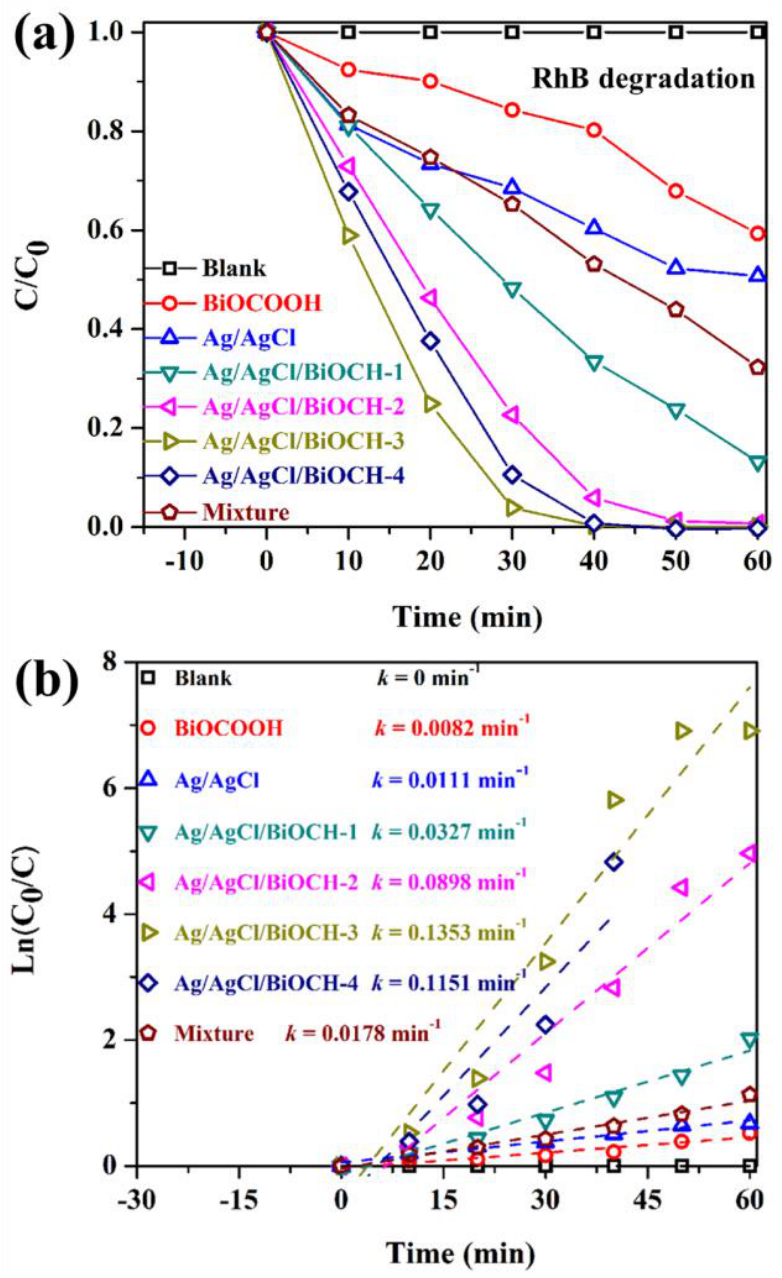
Figure 5. ( a , b ) Photocatalytic removal of rhodamine B (RhB) (10 mg / L, 80 mL) over as-obtained photocatalysts (30 mg) under simulated sunlight.